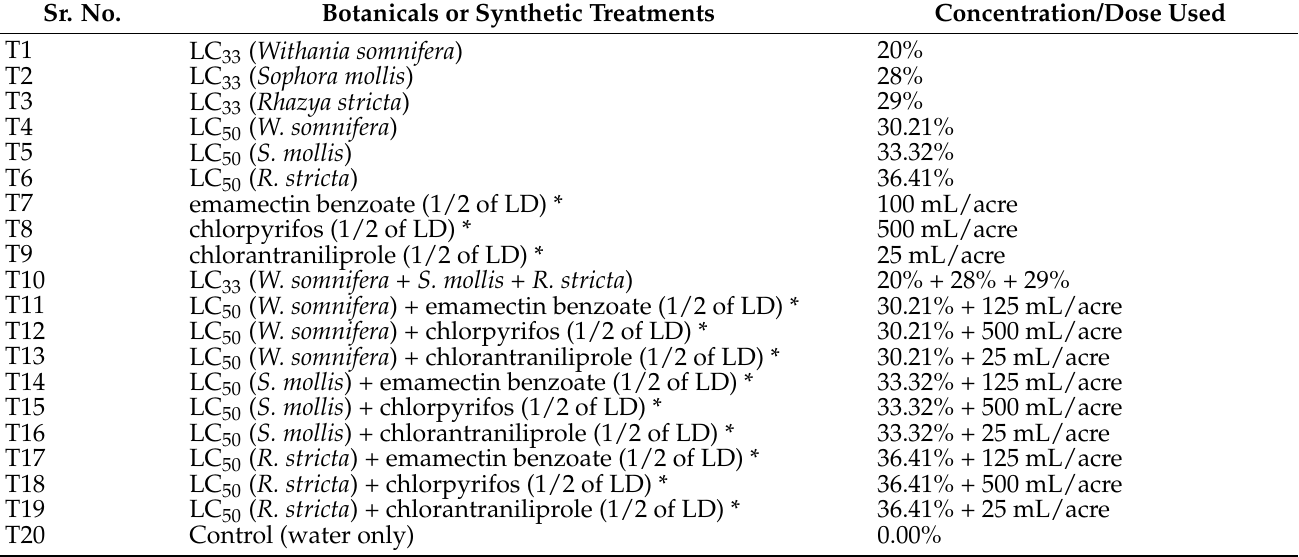
Table 4. Selected effective treatments and their combinations bioassayed against 3rd instar larvae of the fall armyworm Spodoptera frugiperda